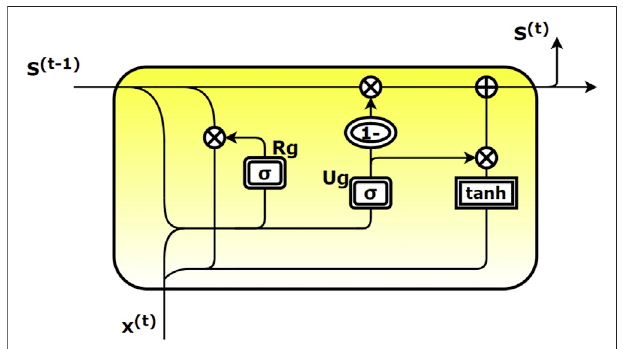
FIGURE 2 | Neuron network of